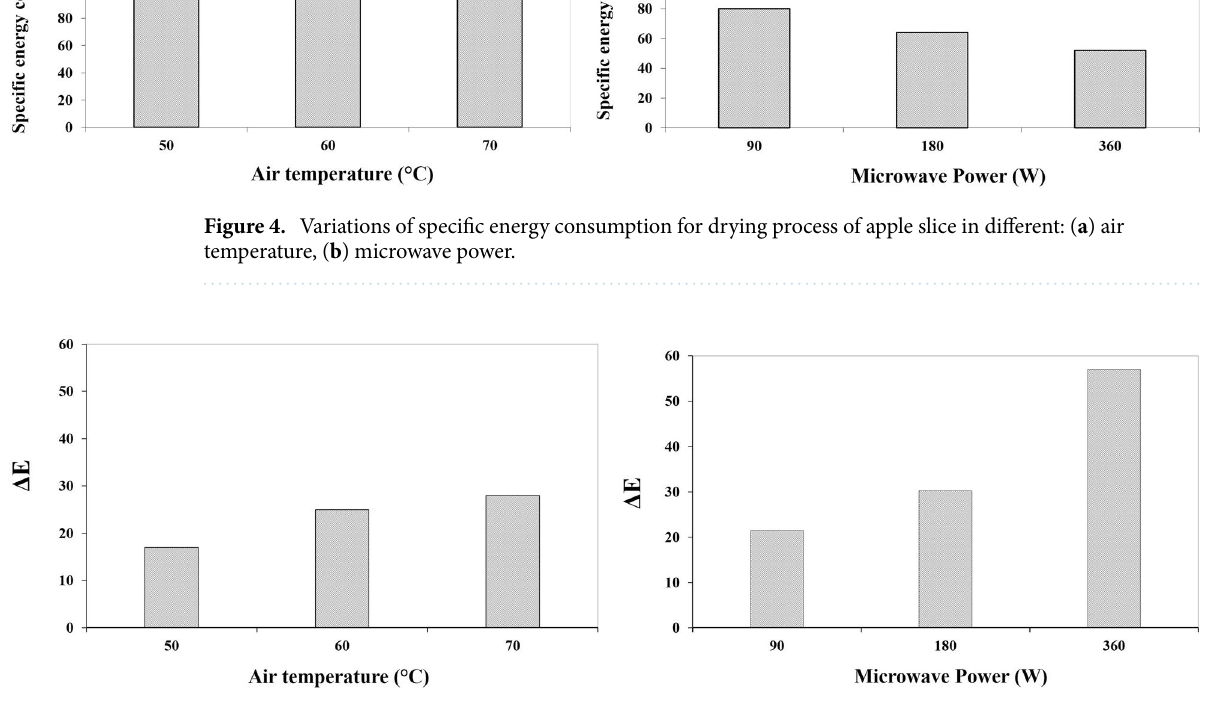
Figure 5. Color change values of apple slices in different ( a ) air temperature, ( b ) microwave